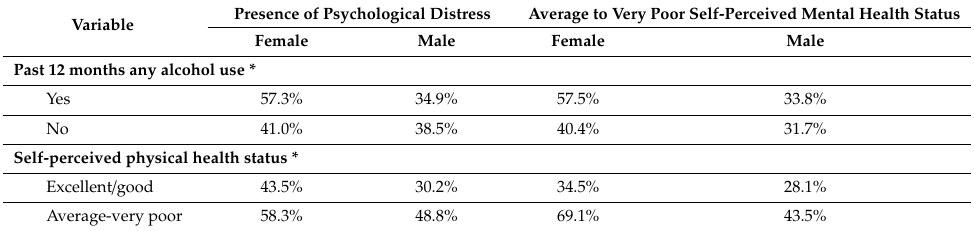
Table 3. Factors a associated with the presence of psychological distress and low self-perceived mental health status, by